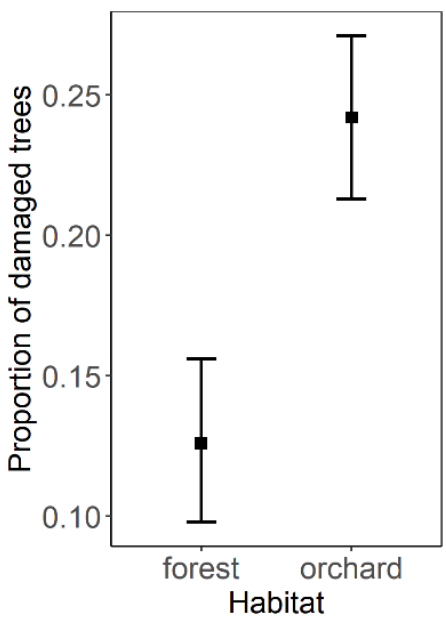
Figure 1. Proportion of damaged trees in studied forests and orchard in 2019.